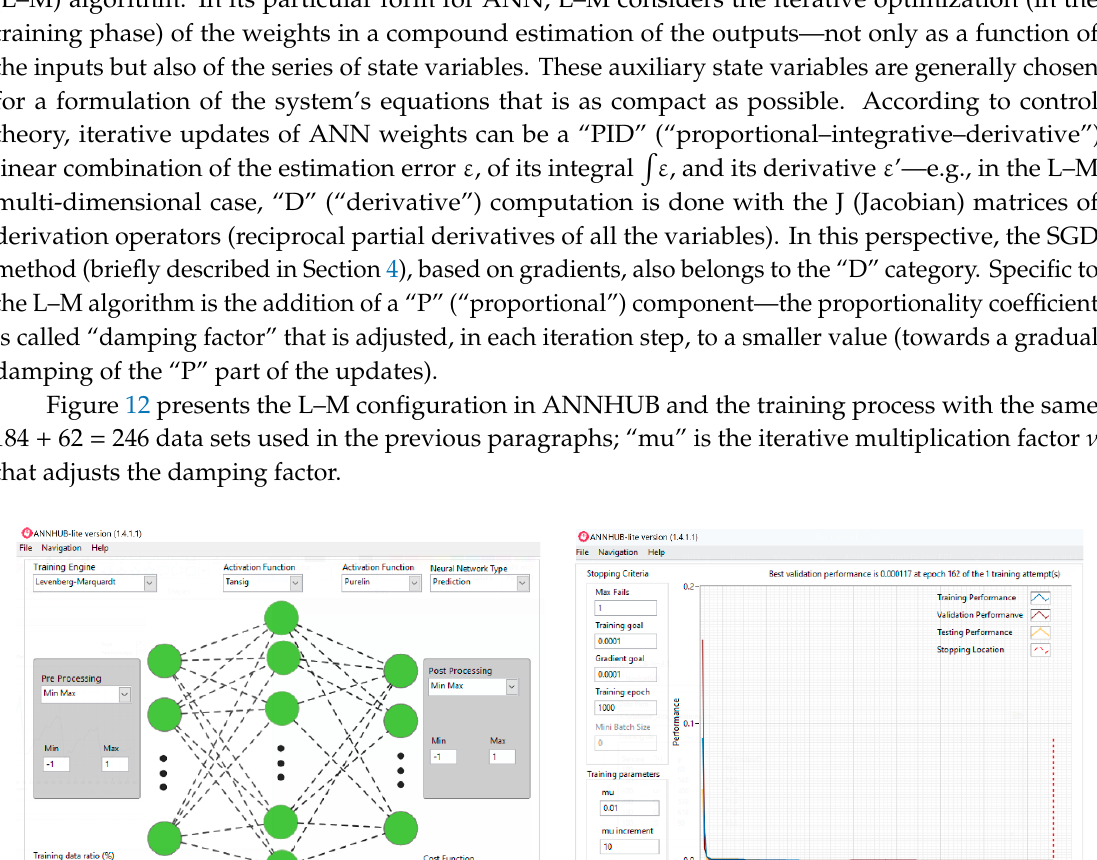
Figure 11. XGBRegressor prediction of effective power (Pe) = 122.855095 kW for load = 90%, speed = 1800 rpm, and exhaust back pressure (EBP) (p) = 250 mmWC.